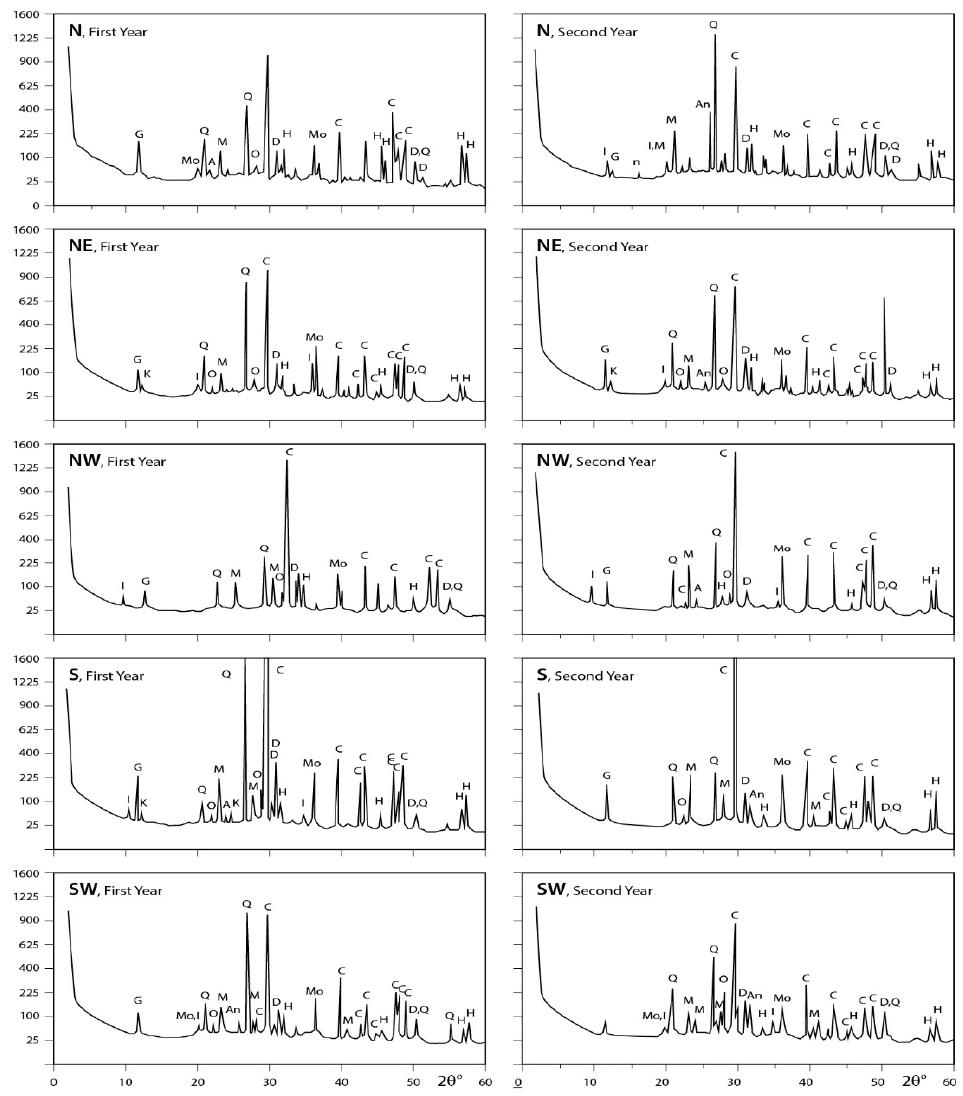
Figure 6. XRD profiles for the analyzed samples; A = albite; An = anhydrite; At = antigorite; C = calcite; D = dolomite; F = feldspar; G = gypsum; H = halite; I = illite; K = kaolinite; M = microcline; Mo = montmorilonite; Ms = muscovite; O = orthoclase; Q = quartz; T = tremolite (N: North; NW: Northwest; NE: Northeast; S: South; SW: